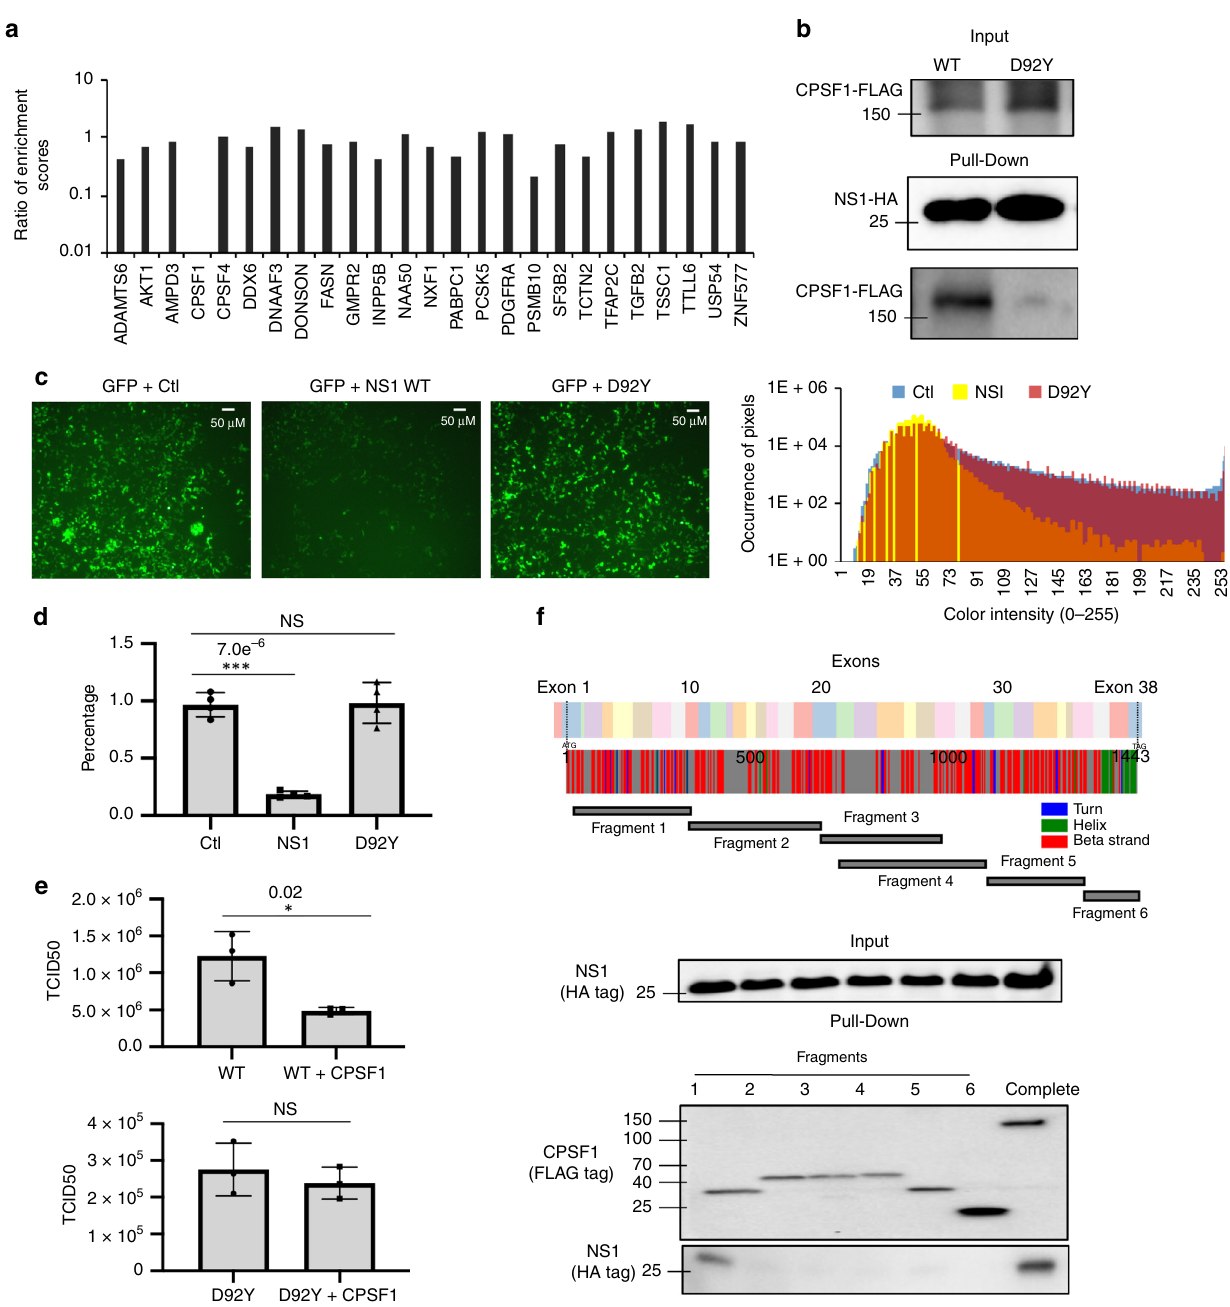
Fig. 5 Mechanistic characterization of an NS1 IFN-sensitive mutation D92Y. a Ratio of average enrichment scores of indicated proteins binding to NS1 versus D92Y mutant ( N = 6 for NS1 protein and N = 2 for D92Y mutant, biologically independent samples). A lower ratio represented a stronger loss of binding for D92Y mutant. b Interactions between CPSF1 and NS1 proteins (WT and D92Y mutant) were examined by immunoprecipitation. c Inhibition of protein expression by WT or D92Y NS1 proteins using GFP reporter. GFP reporter was transfected in 293T cells together with WT or D92Y NS1 expression plasmid. Fluorescence intensity was examined 24-h post transfection. Empty vector was used as a control. Three biological replicates were performed, and a representative experiment is shown. The histogram of fl uorescence intensity is shown on the right panel. K – S test of green channel intensity distribution between NS1 and Ctl shows P < 2.2e − 16 . d Mature GFP mRNA was examined by poly-A-speci fi c reverse transcription and real-time PCR relative to GAPDH. Empty vector was used as a control ( N = 4 biologically independent samples). e Effect of CPSF1 overexpression on the replication of WT or D92Y mutant viruses ( N = 3 biologically independent samples). Viral titer was examined by TCID50 assay. f Interactions between NS1 proteins and CPSF1 fragments were examined by immunoprecipitation (IP)-western. The arrangement of exons, secondary structures, and the range of amino acids of each fragment is shown. Three biological replicates were performed, and a representative experiment is shown. Data are presented as mean values + / − SD for panels d and e . * P < 0.05, ** P < 0.01, *** P < 0.001 (two-tailed t test, the exact P- value is labeled on the fi gure). Source data for a , b , d , e , f is provided in Source Data fi